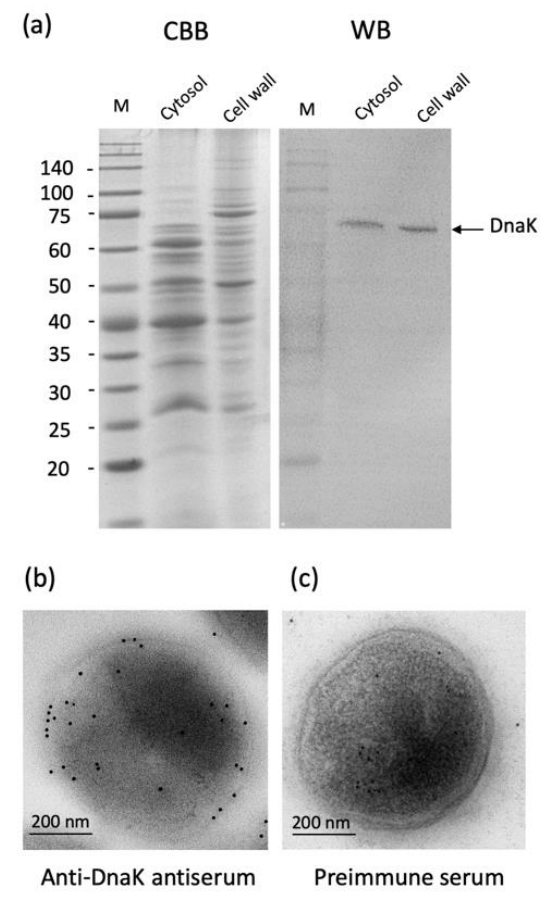
Figure 3. Localization of A. defectiva DnaK. The proteins cell lysate and cell envelope compartments were subjected to SDS-PAGE, and proteins were either stained with Coomassie Brilliant Blue (CBB) or transferred to an Immobilon-P membrane for Western blotting using the anti-DnaK antiserum ( a ). Immunoelectron microscopy was performed to confirm the localization of A. defectiva DnaK. The sections prepared were incubated with either rabbit anti-DnaK antiserum ( b ; dilution, 1:100) or preimmune serum ( c ; dilution, 1:100) for 48 h at 4 ◦ C. After washing with 0.1 M TBS, the sections were incubated with 1:100 dilution of goat polyclonal anti-rabbit IgG-gold (10 nm; Abcam, Cambridge, UK) for 2 h at